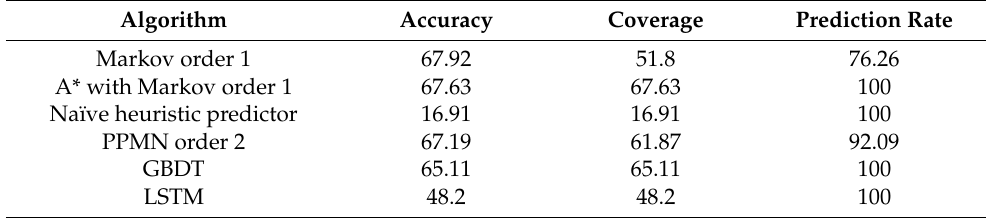
Table 3. Comparison between different predictors on the mixed dataset.